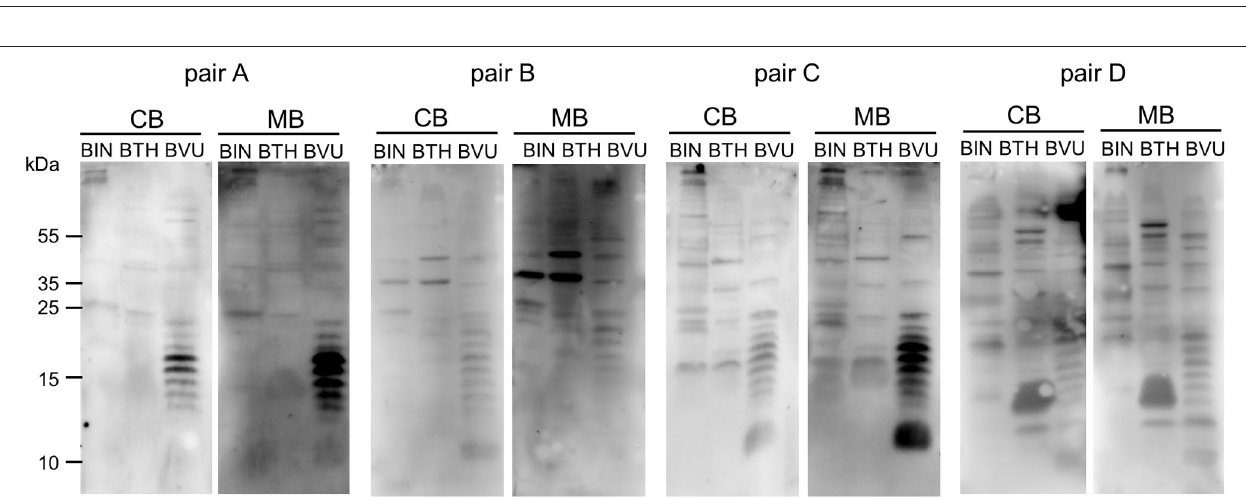
FIGURE 6 | (dashed line). Histograms are related to data presented in (A) . (C) IgM reactivity to B. thetaiotaomicron for cord blood (CB) and maternal blood (MB) samples ( n = 23). (D) IgM reactivity to B. thetaiotaomicron for matched pairs of cord blood (green) and maternal blood (black). Untreated bacteria are displayed in gray (dashed line). Histograms are related to data presented in (C) . (E) IgM reactivity to B. vulgatus for cord blood (CB) and maternal blood (MB) samples ( n = 26). (F) IgM reactivity to B. vulgatus for matched pairs of cord blood (green) and maternal blood (black). Untreated bacteria are displayed in gray (dashed line). Histograms are related to data presented in (E) . Results with p -value < 0.05 are marked with asterisks.